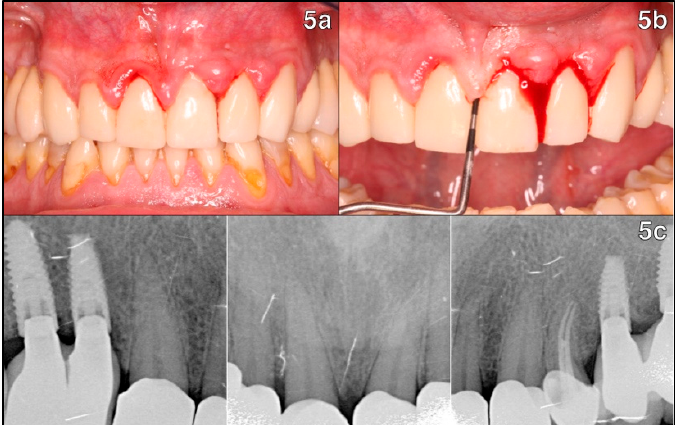
Figure 5. Intraoral examination of teeth 1.3-1.2-1.1-2.1-2.2-2.3: ( 5a ) pockets and spontaneous bleeding are evident; ( 5b ) profuse bleeding on probing can be observed, as well as deep pseudosockets up to 7 mm on teeth 12-11-21-22; ( 5c ) periapical radiographs in the aesthetic region which show implant supported prostheses on teeth 1.5-1.4-2.4-2.5, root canal treatment in 2.3 and full coverage crowns